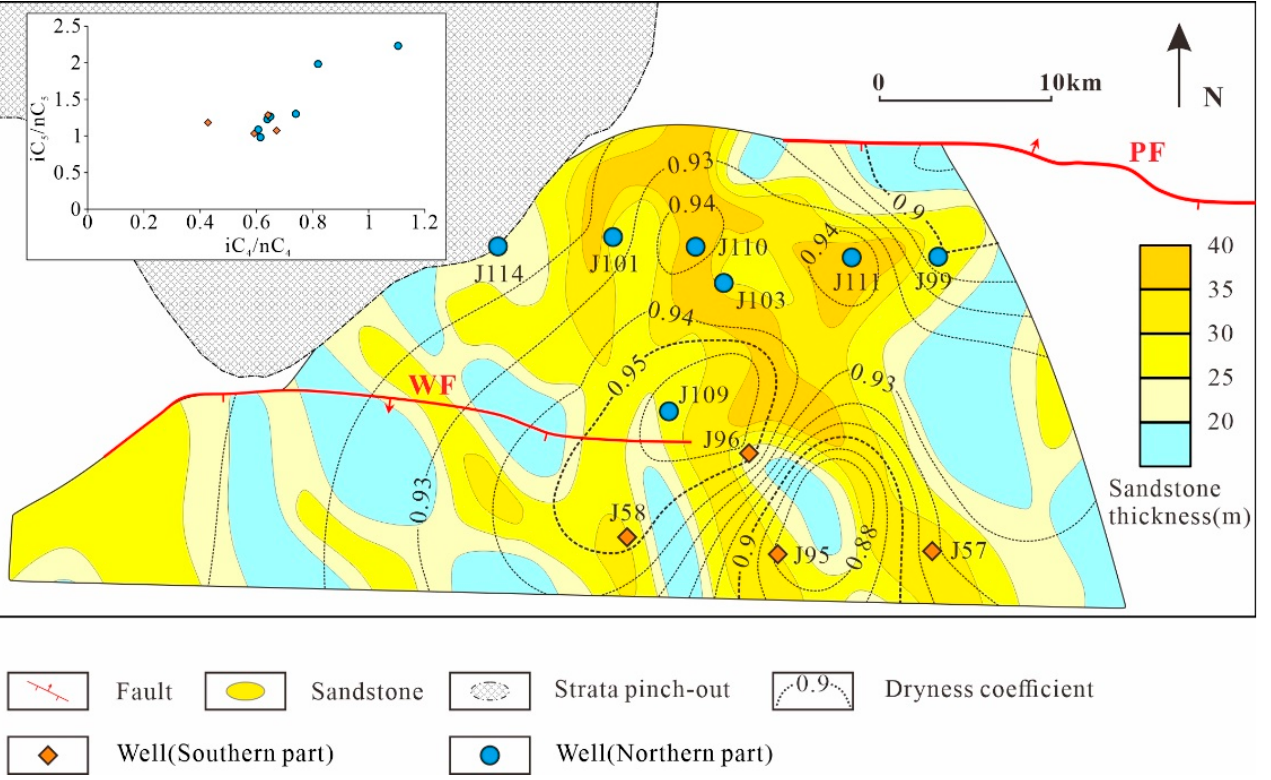
Figure 13. Composite map of tight gas dryness coefficient and sandstone thickness distribution of Lower Shihezi Formation with the iC 4 /nC 4 vs. iC 5 /nC 5 relation of tight gas in the northern and southern parts, respectively.